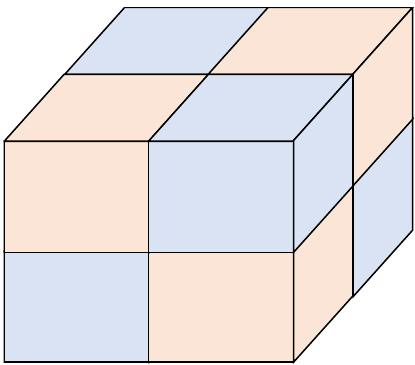
Figure 1: A cellulation of a d -torus with two colors ( d = 3). The union of the cells of one color becomes a disjoint union of topological balls upon deletion of a small neighborhood of the ( d − 2 )